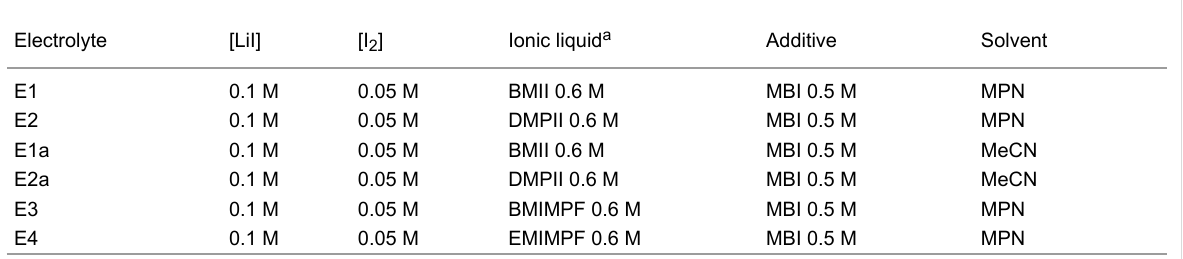
Table 1: Compositions of electrolytes E1, E1a, E2, E2a, E3 and E4. Electrolyte